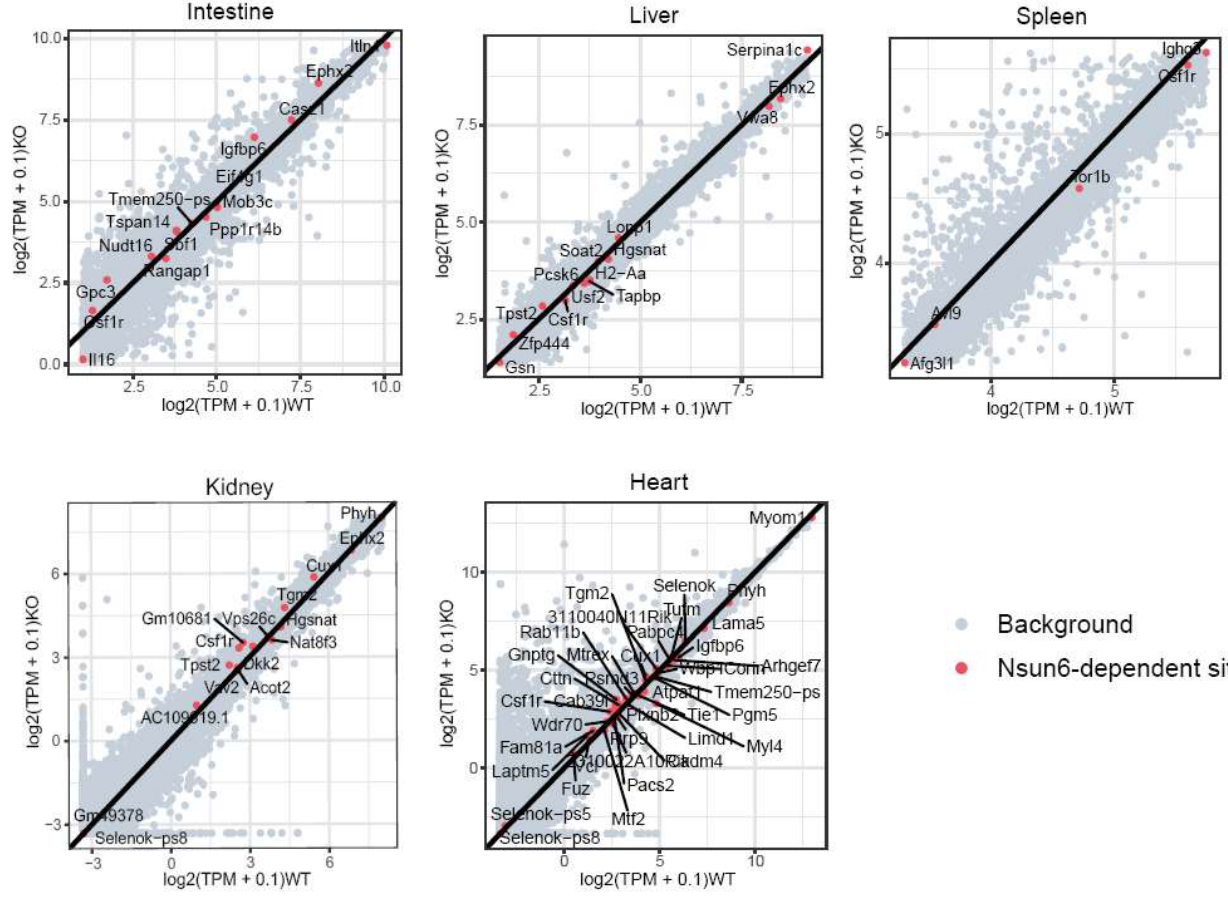
Figure 5. Scatter plots presenting the mRNA level changes of Nsun6 target genes. Scatter plots presenting the mRNA levels of all genes detected in WT and KO tissues. The red dots represent Nsun6 target genes, while the gray dots represent the rest of the genes detected in the tissue. The black line is the diagonal line used as reference.